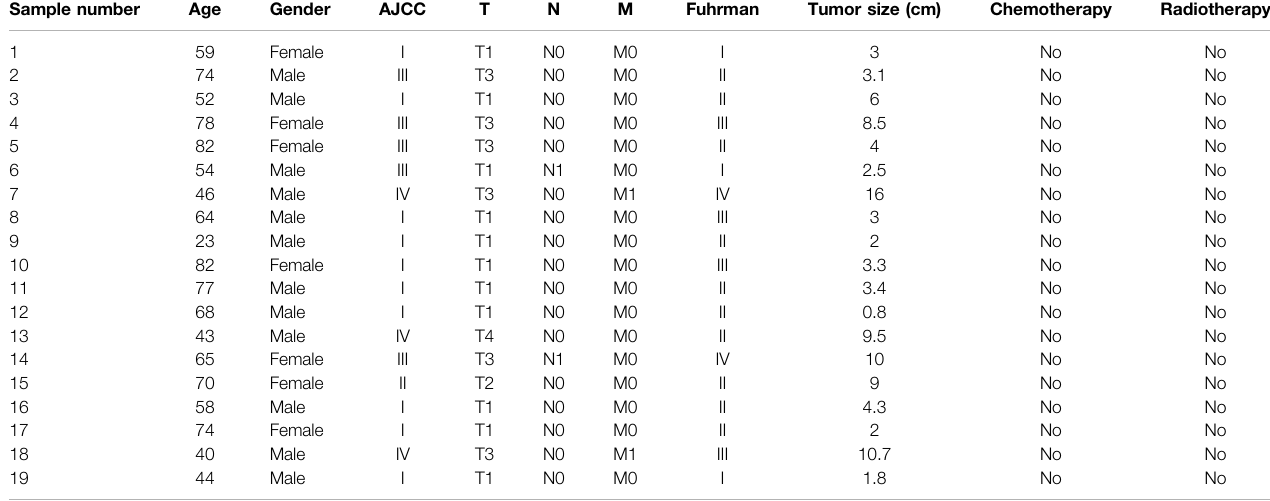
TABLE 1 | Clinical characteristics of 19 ccRCC patients. Sample